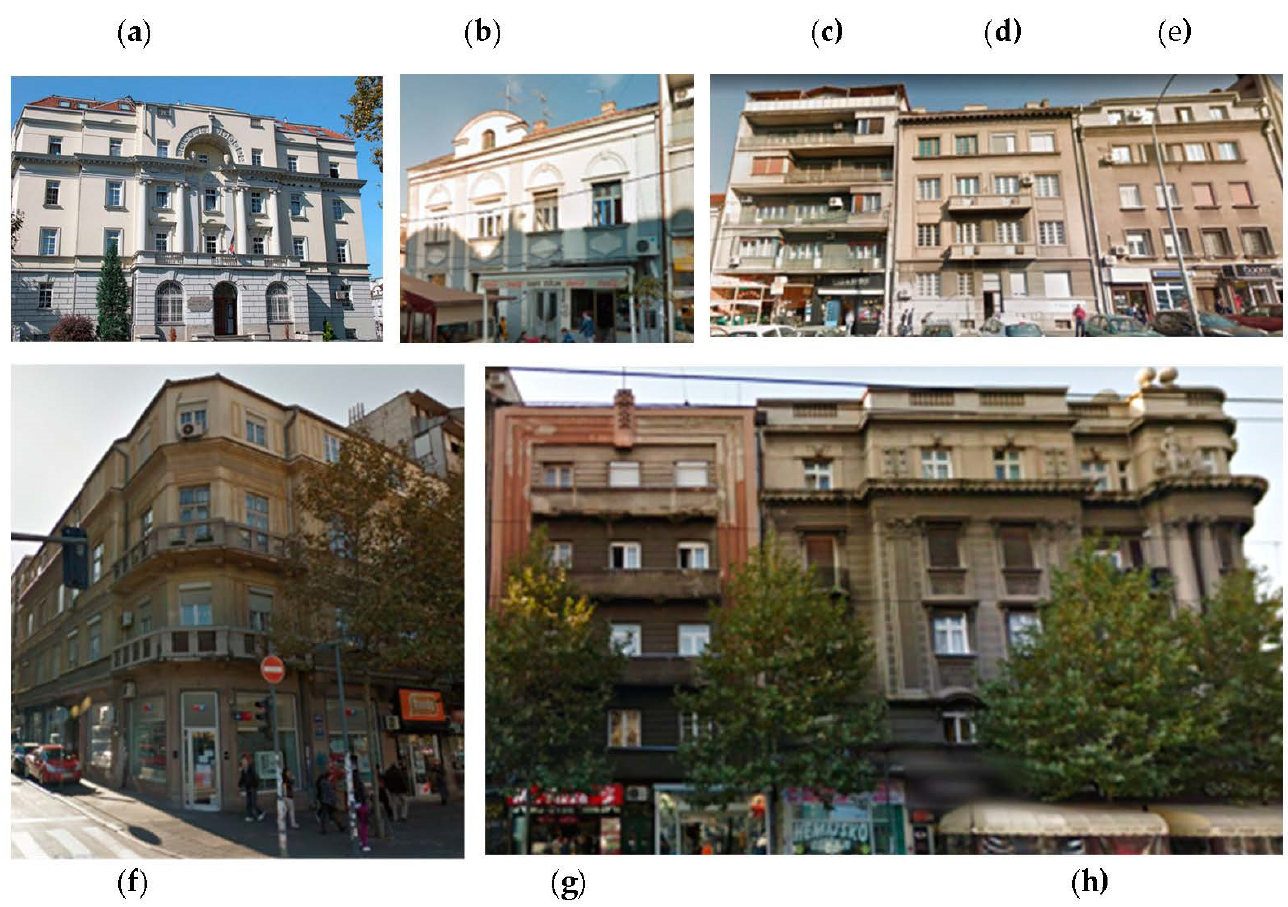
Figure 11. The buildings assessed for the Belgrade study; © Google.